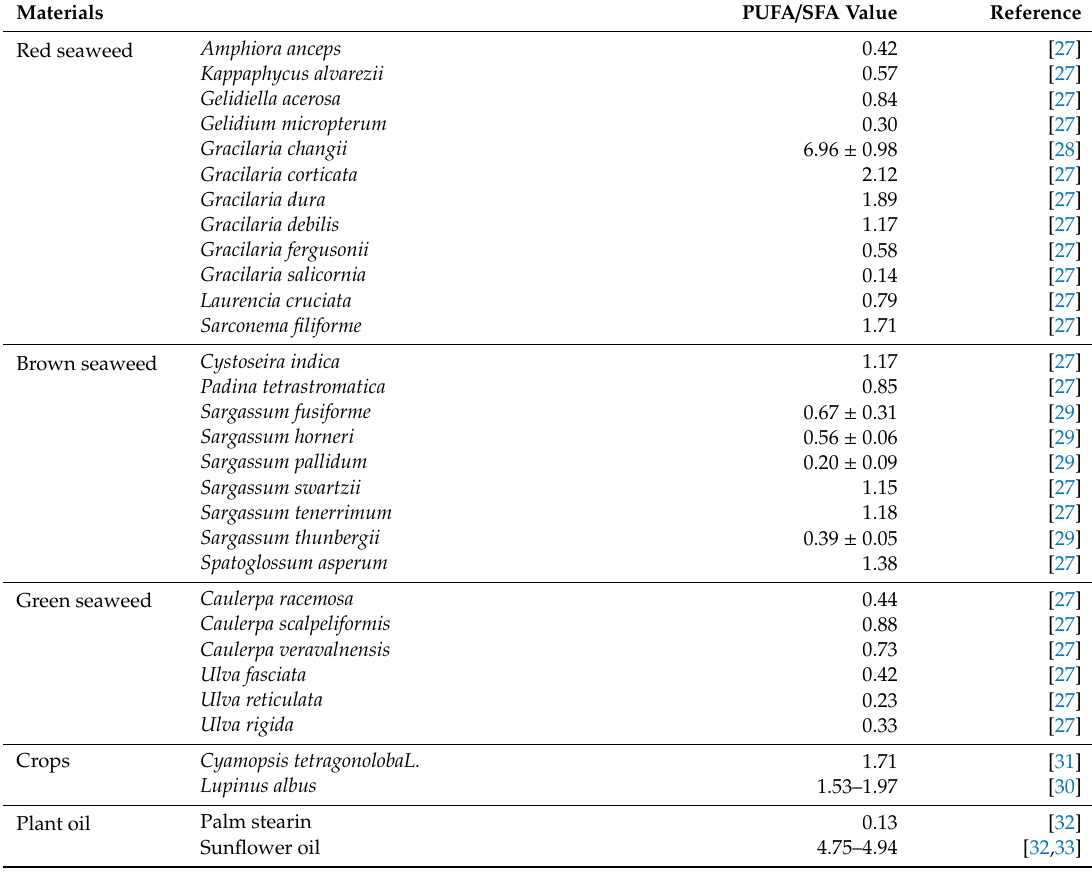
Table 2. Application of PUFA / SFA in fatty acid evaluation